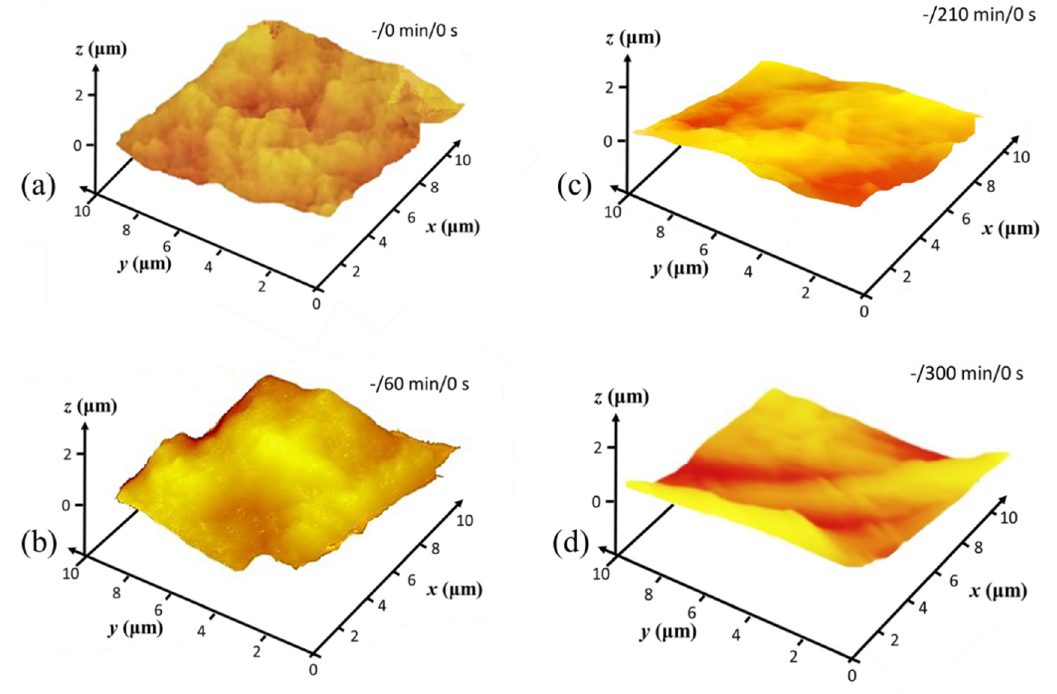
Figure 12. AFM surface profile plots prior to plasma exposure, showing how enzymatic pretreatment generates increased surface nanoscale smoothness (smoother texture between larger scale undulations) during formation of derived MNFC films: ( a ) un-pretreated, ( b ) 60 min, ( c ) 210 min, and ( d ) 300 min of enzymatic hydrolysis pretreatment, respectively.